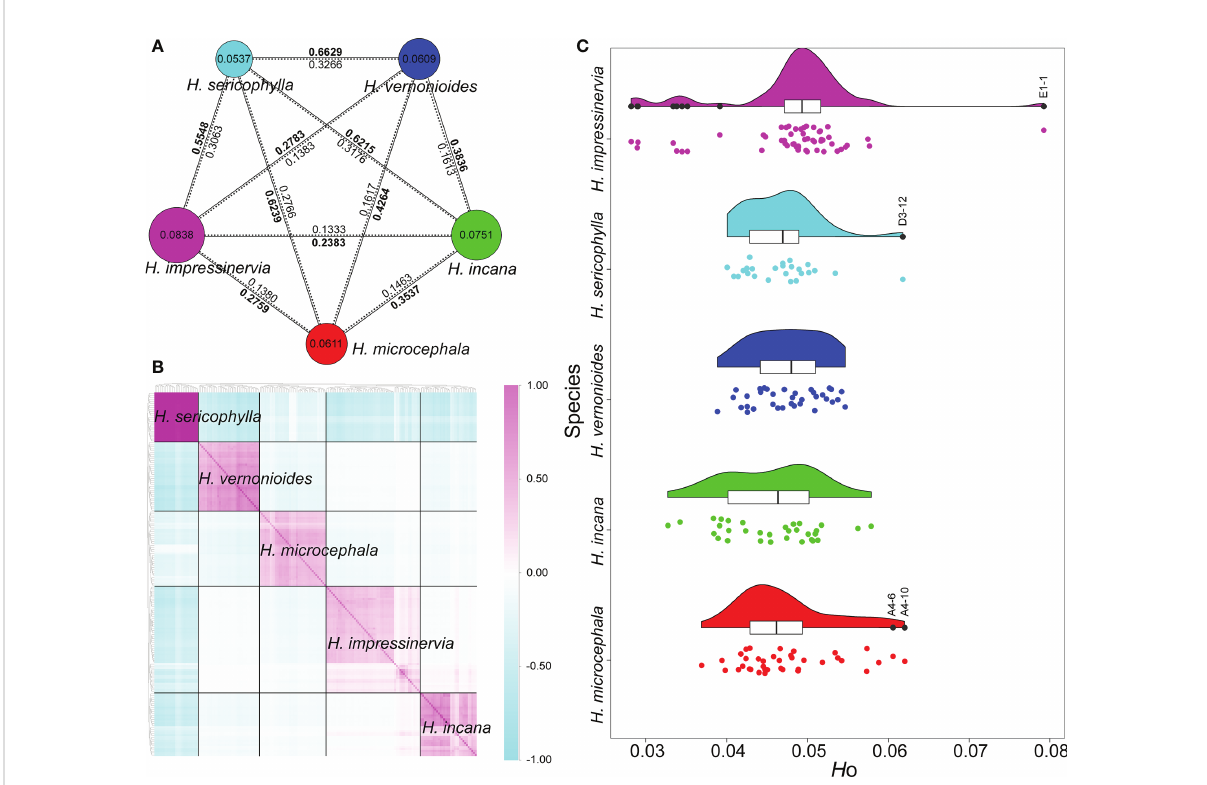
FIGURE 2 Genetic diversity and genetic differentiation, kinship coef fi cients, and heterozygosity of Heteroplexis species. (A) The size of a circle and the value inside denote genetic diversity ( p ) level. Values of genetic differentiation coef fi cients ( F ST ) are in bold on the solid lines, and values of absolute sequence divergence ( D XY ) are on the dotted lines. (B) Intra- and interspeci fi c identity-by-state (IBS) kinship coef fi cients. (C) Observed heterozygosity ( H o) of